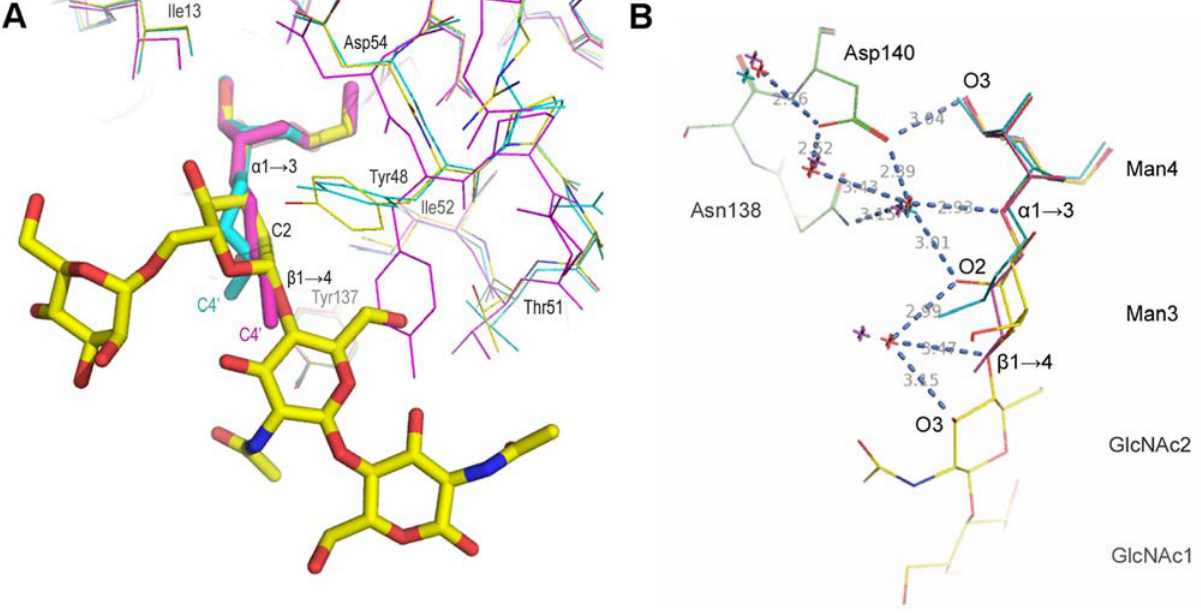
Figure 5. Specificity spots for interaction with FimH. A , Superposing the FimH RBDs with the oligomannose-3 ligand (yellow, PDB entry 2vco, 2.1 A˚ resolution), with butyl a - D -mannose (magenta, 1uwf, 1.7 A˚ resolution) and with butyl a - D -mannose (cyan, 1tr7, 2.1 A˚ resolution). Tyr48 in the 1uwf structure (magenta) adopts a different side chain conformation, for the reason to avoid clashes in the crystal packing. The butyl tail takes on a conformation that matches the C3-C2-C1 greasy trace of the central Man3 almost precisely. B , Water positions in the crystal structures of the FimH RBD (green) in complex with the oligomannose-3 ligand (yellow, waters in red and hydrogen bonds in blue dashed lines) match those of the FimH RBDs of the butyl a - D -mannose-liganded structures (waters in magenta for 1uwf, waters in cyan for 1tr7).